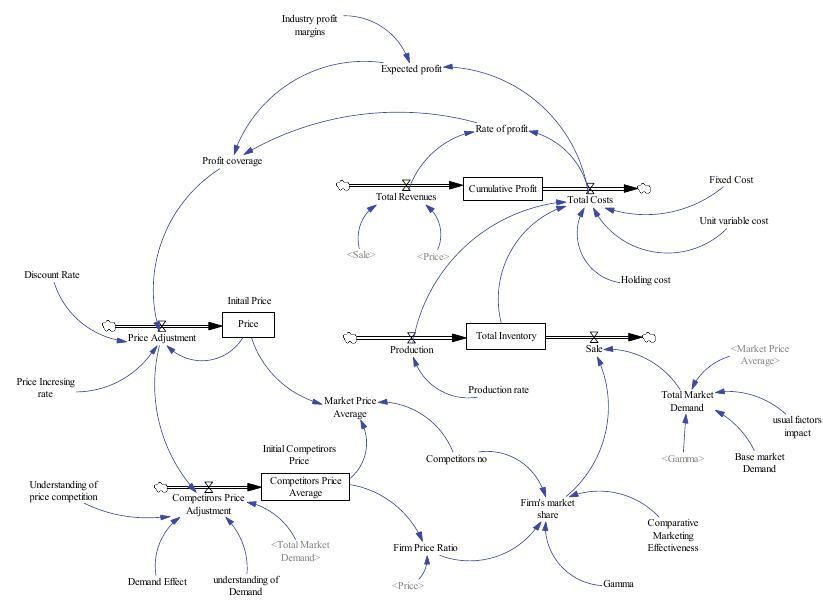
Fig. 6. The output of inventory